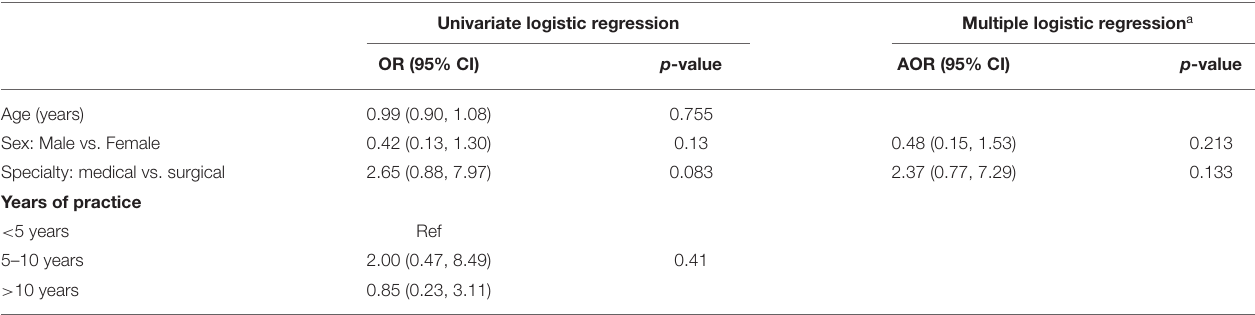
TABLE 5 | Factors associated with “knowing what oncofertility was” among oncologists ( n = 60). Univariate logistic